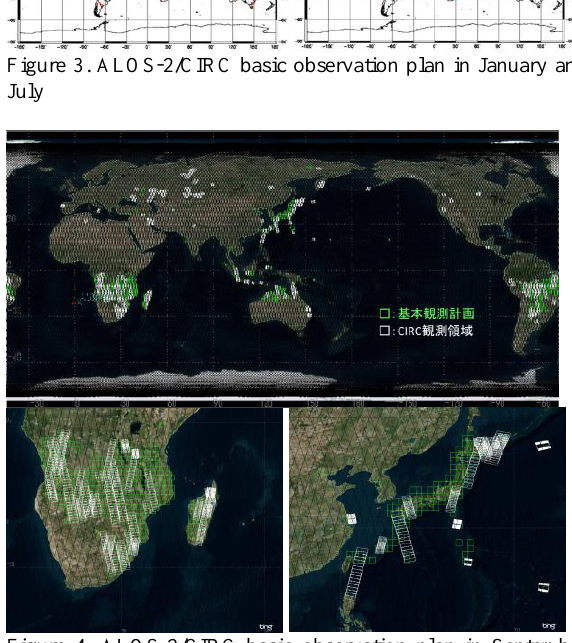
Figure 4. ALOS-2/CIRC basic observation plan in September (Green Box) and planning example of a recurrence cycle (White